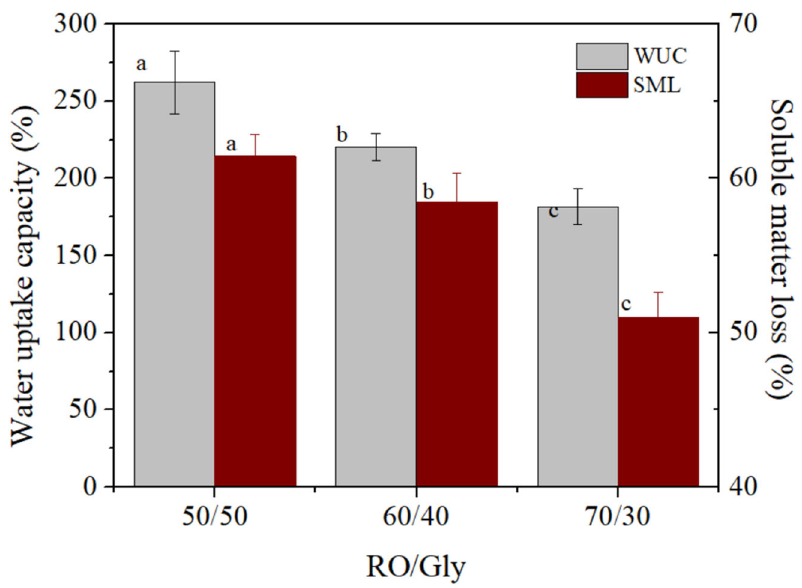
Figure 6. Water uptake capacity and soluble matter loss for the RO/Gly systems: 50/50, 60/40 and 70/30. Different letters (a, b, c) within the same column parameter (WUC or SML) indicate significant differences ( p < 0.05).